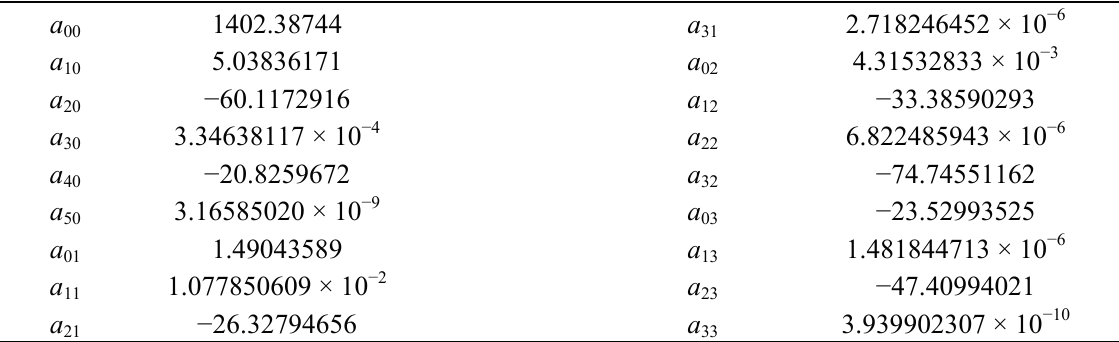
are listed (cid:2924)(cid:2924)